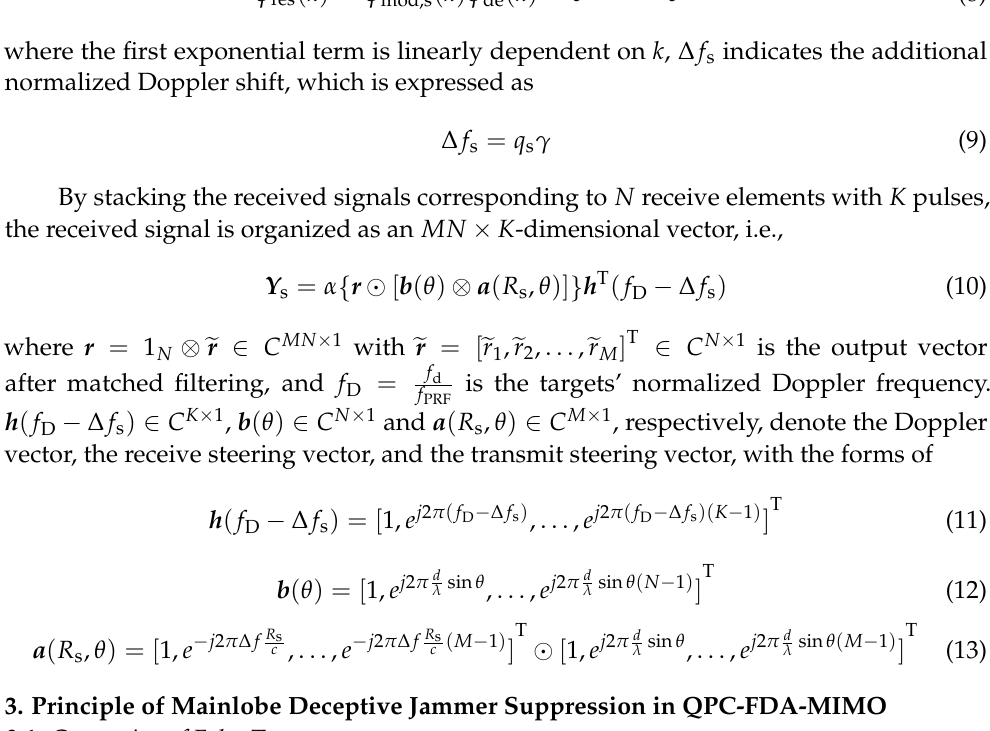
indicates the additional